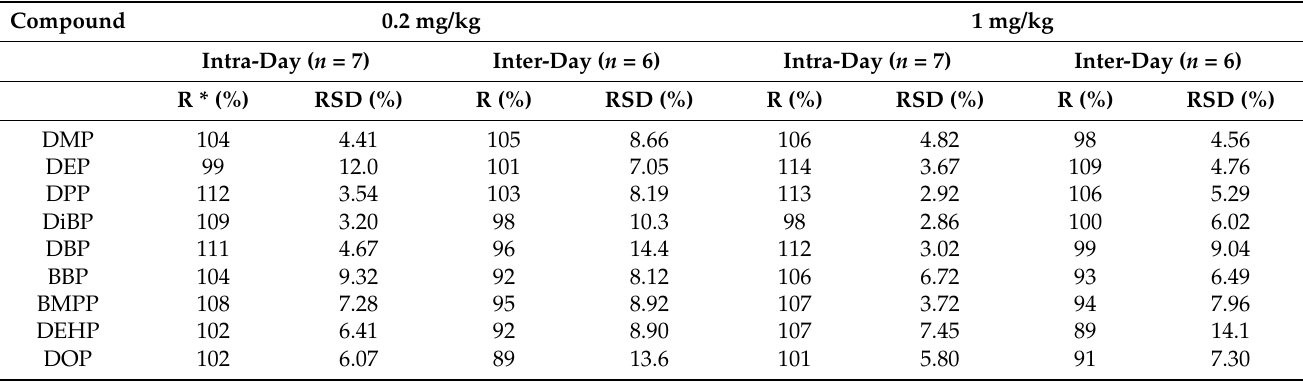
Table 3. Recovery of 0.2 and 1 mg/kg phthalates in palm